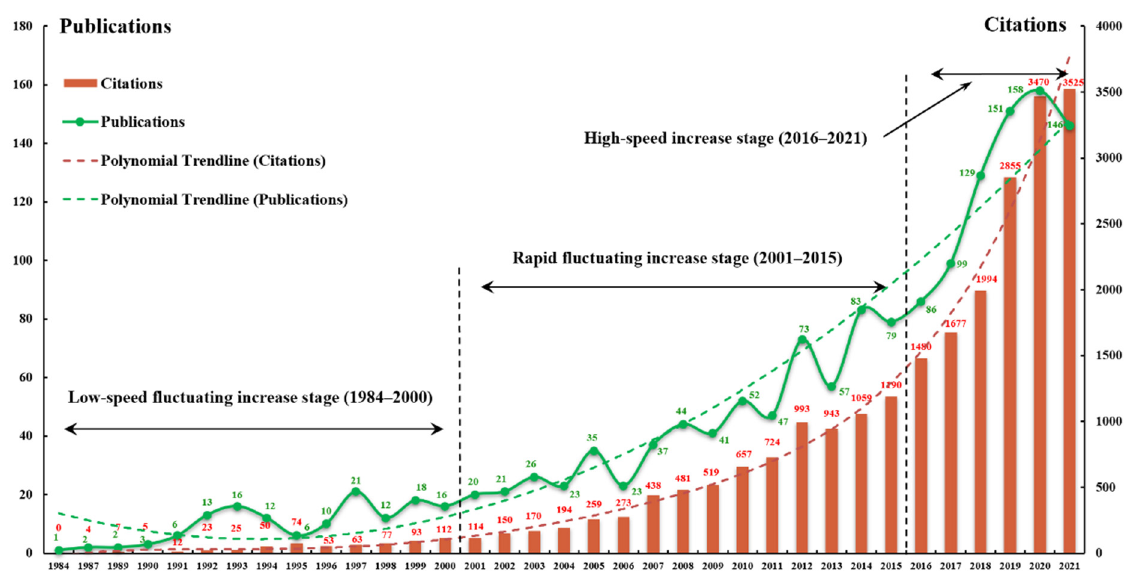
Figure 2. The annual number of publications and citations in LTCI field from 1984 to 2021.